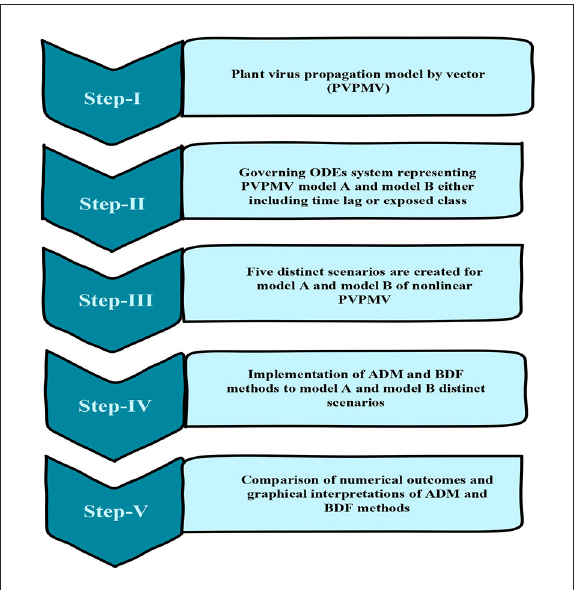
FIGURE1 Working procedure of design approach for non-linear PVPMV.